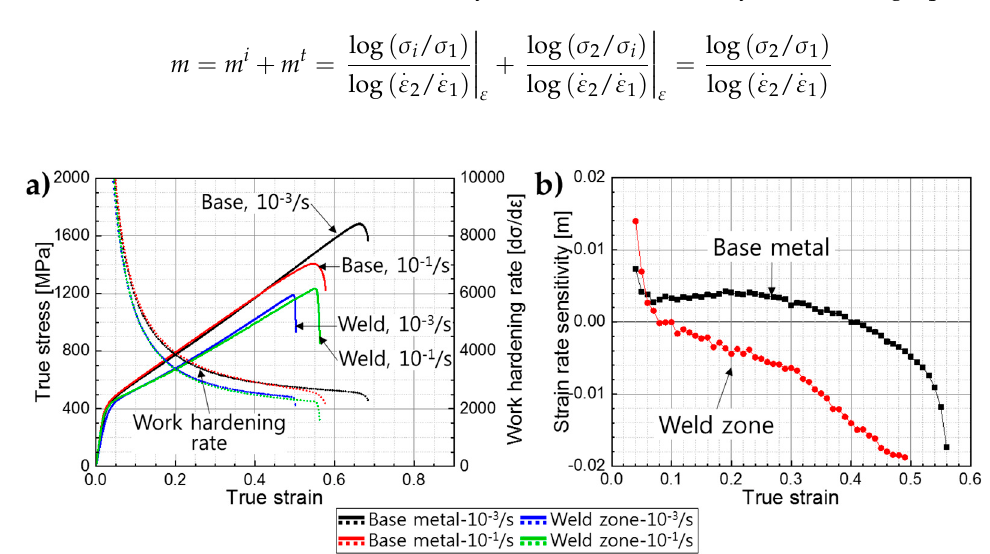
Figure 9. SEM images of fractographs depending on the strain rate: ( a ) and ( b ) the base metal and the weld metal with strain rate of 10 − 3 /s, ( c ) and ( d ) the base and the weld metal with strain rate of 10 − 1 /s.